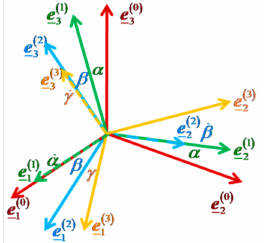
Figure 2. The Cardan